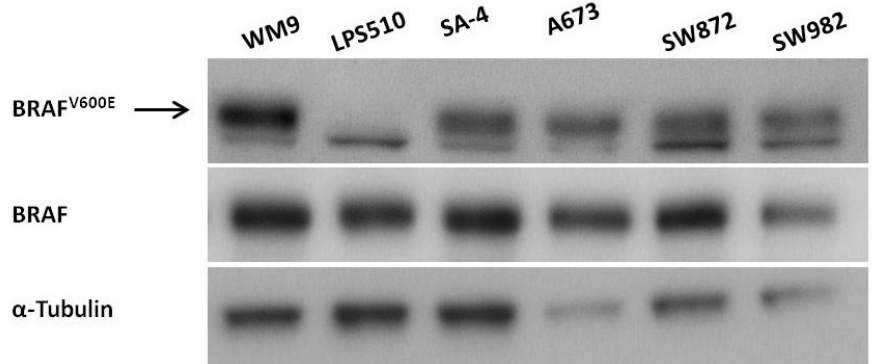
Figure 1. Expression of BRAF V600E protein in sarcoma cell lines. The presence of BRAF V600E mutated protein was evaluated in the five sarcoma cell lines (LPS510, SA-4, A673, SW872, SW982). The melanoma cell line WM9 (with BRAF V600E ) and LPS510 (with wild-type BRAF) were included as control cell lines. Cell lysates were analyzed by western blotting, using indicated antibodies. α-Tubulin served as protein loading control. Arrow indicates the expected size of BRAF V600E , and an unspecific band was observed below this band for all cell types.